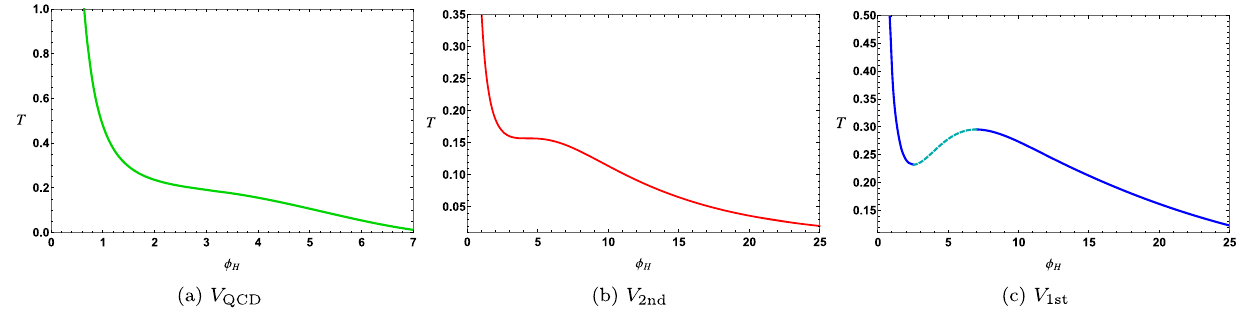
Fig. 1 The temperature T v.s. horizon φ H for the dilaton potentials V QCD (left), V 2nd (middle) and V 1st (right) Fig. 2 The square of speed of sound c 2 s ( a ), entropy density s ( b ), specific heat C v ( c ) and free energy F ( d ) v.s. temperature